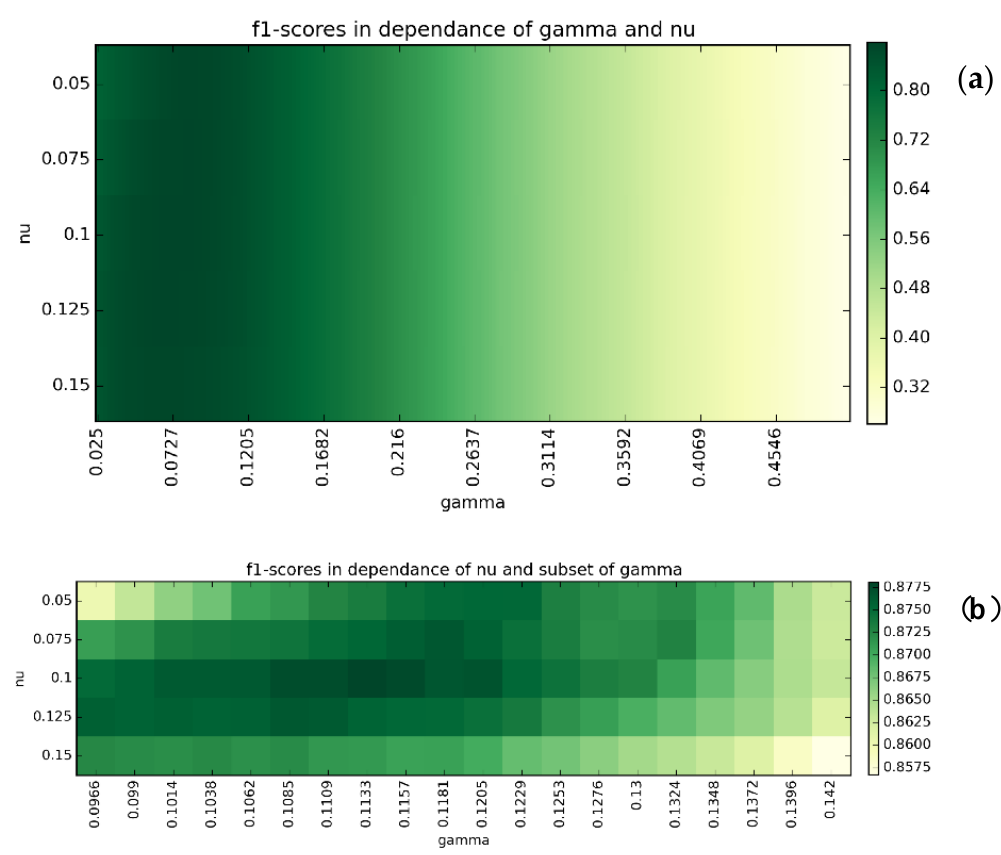
Figure 4. Results of the parameter grid search. ( a ) The f1-scores for all ν and ɣ combinations from the grid search; ( b ) a subset of ν and ɣ combinations around the one with the highest overall f1-score.